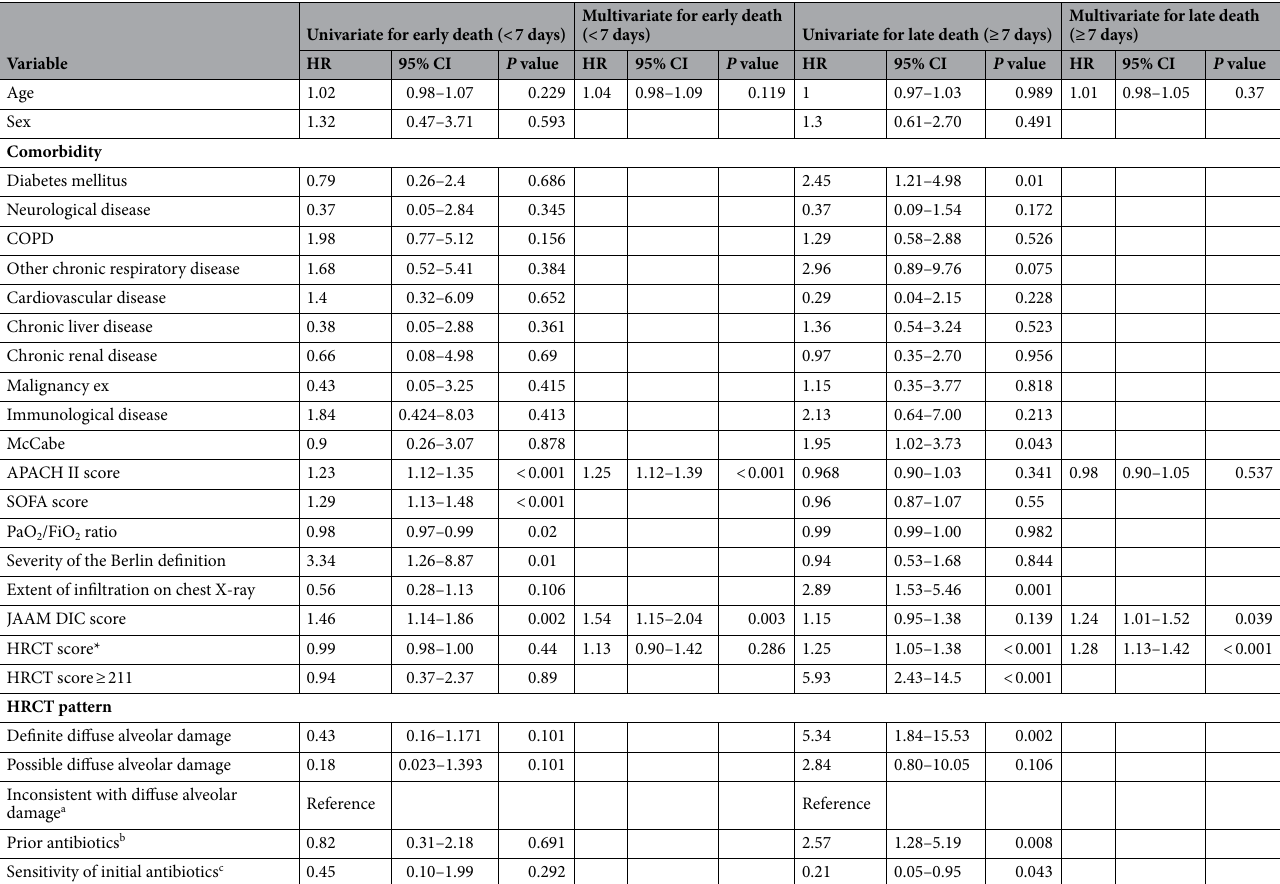
Table 3. Univariate and multivariate analyses of mortality. Univariate and multivariate analyses for the early death were performed among the groups (the early death group (n = 18) vs. the late death group (n = 32) plus survived one (n = 54)). Univariate and multivariate analyses for the late death were performed between the late death group (n = 32) and survived one (n = 54). SOFA sequential organ failure assessment, JAAM DIC score Japanese Association of Acute Medicine disseminated intravascular coagulation score, HRCT score high- resolution computed tomography score. *The hazard ratio of the HRCT score is expressed as mortality change per 10% increase in area of attenuation with traction bronchiectasis on high-resolution CT. a Inconsistent with diffuse alveolar damage pattern was used as a reference to calculate the relative risk of the other two patterns. b Prior antibiotics; No. of cases, Early death: 6 (33%), Late death: 18 (56%), Survived: 15 (28%). c Sensitivity of initial antibiotics; Number of cases where no bacteria were detected in culture, Early death: 3(17%), Late death: 17(53%), Survived: 11 (20%). b,c Prior antibiotics and sensitivity of initial antibiotics were excluded from multivariate analysis because of the uncertainty and the large number of cases where organism was not detected in